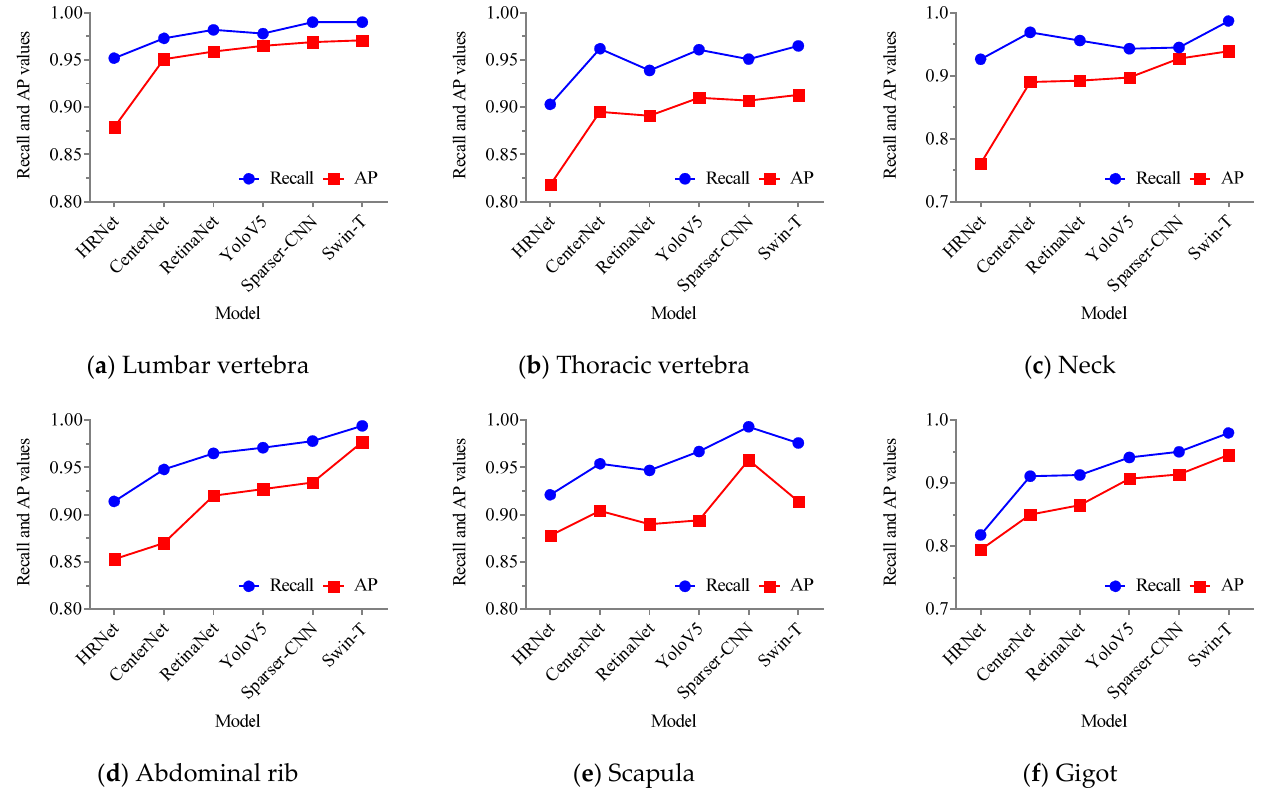
Figure 16. Comparison of Recall and AP values of each mutton parts obtained by the proposed model and other models for the validation set.